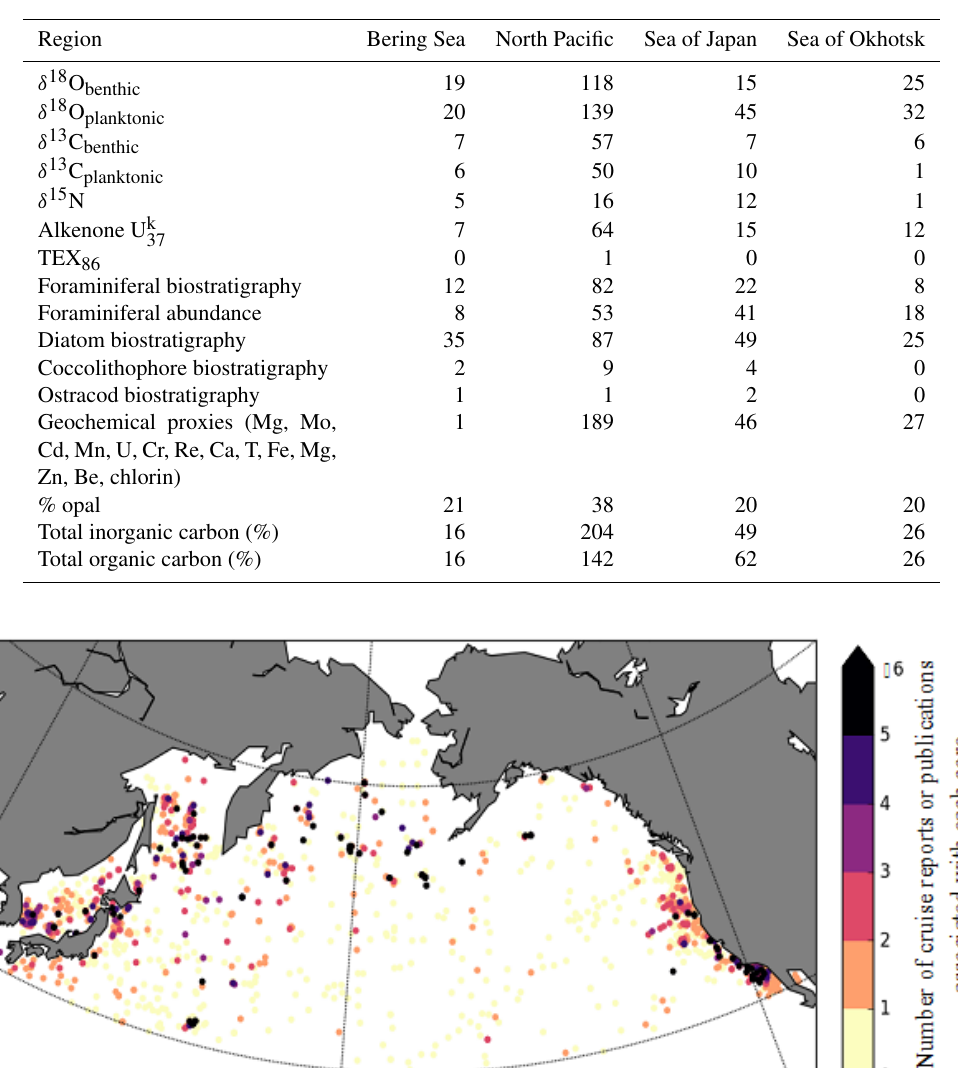
Table 4. Regional summary of isotopic, geochemical, biological, and sedimentary proxies. Benthic and planktonic isotopic analysis is for all cores, including, but not limited to, isotope analysis used in core chronology development.